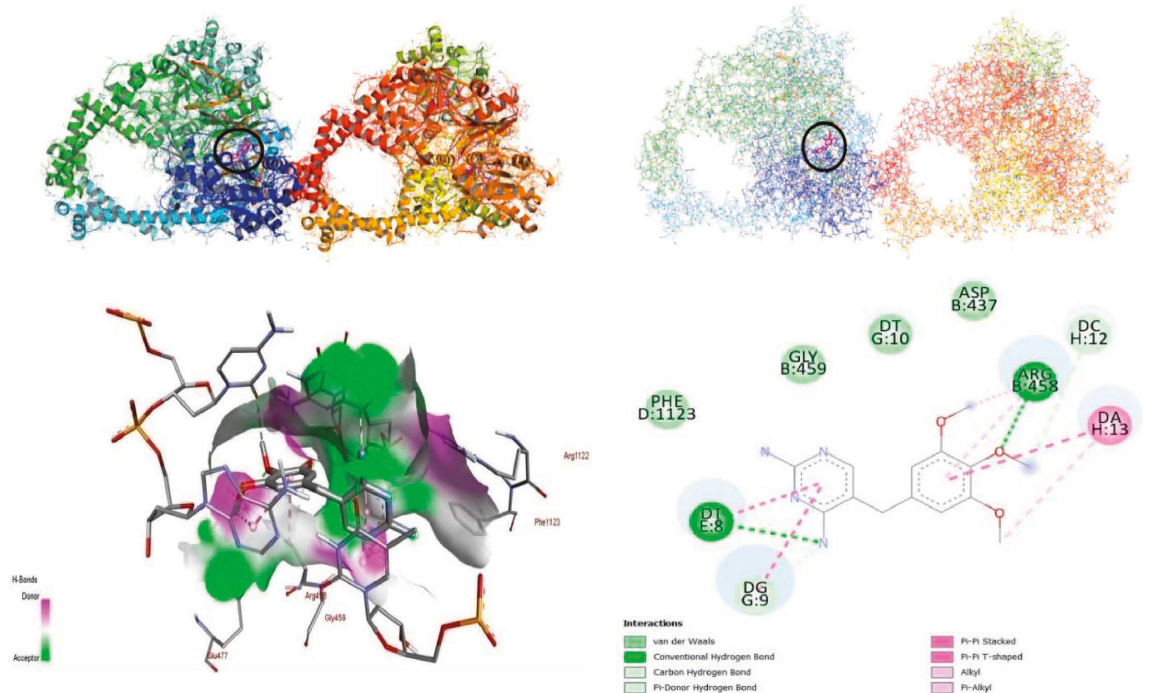
Figure 20: The two- and three-dimensional show of modes of binding by